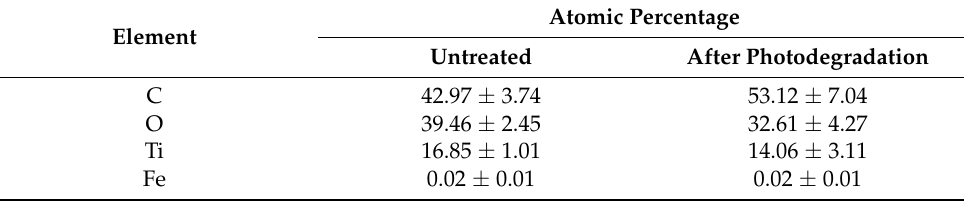
Figure 14. Radiant power of ( a ) Blue LED and ( b ) commercial LED bulbs. Table 6. Elemental analysis on the surface of Fe/TiO 2 –cMDF (commercial LED bulbs, 12